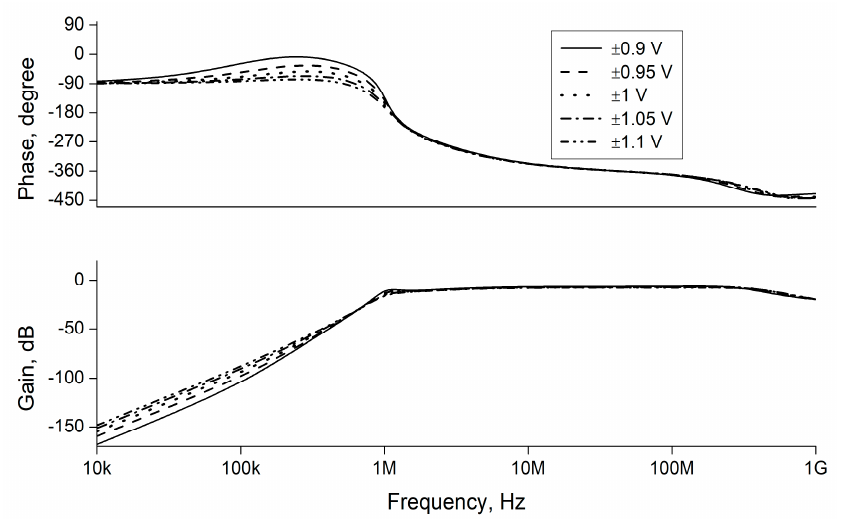
Figure 15. Frequency responses of the HP ladder filter for different power supplies.